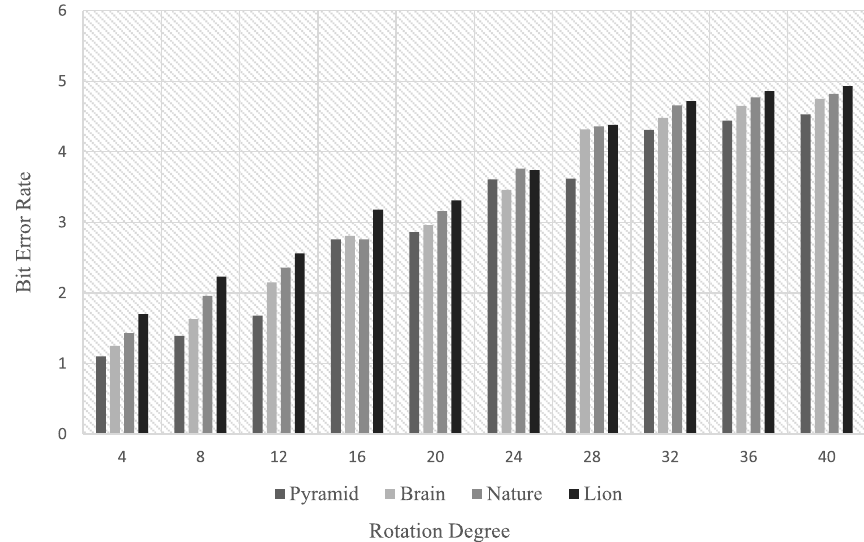
Fig. 26 The (Bit Error Rate) results towards different image’s rotation